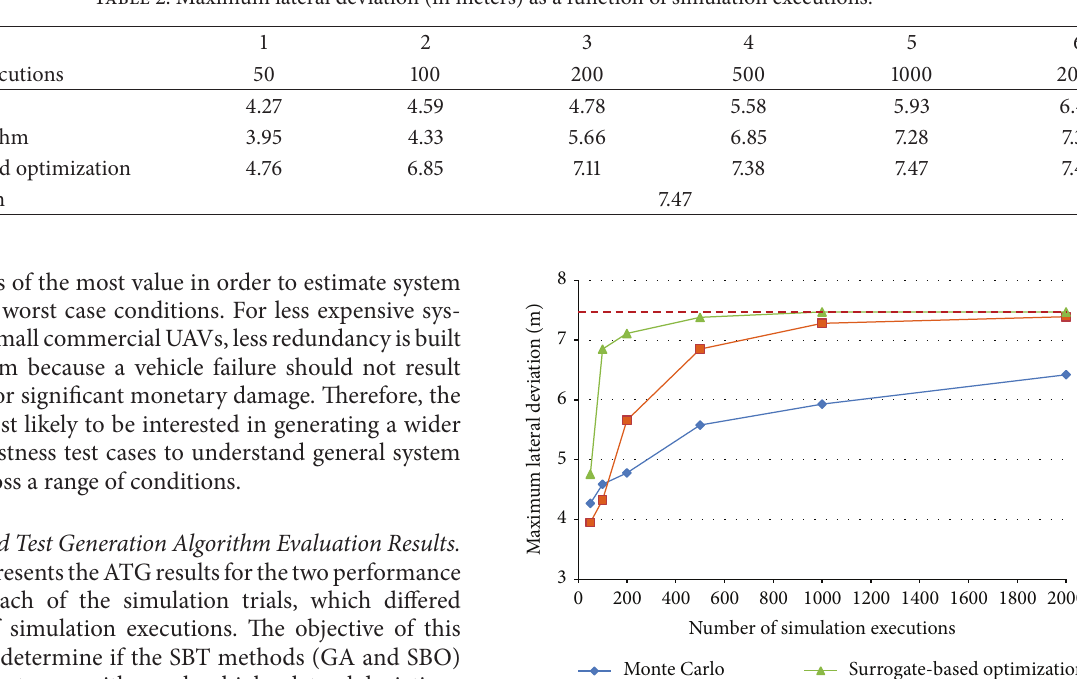
Table 2: Maximum lateral deviation (in meters) as a function of simulation executions.